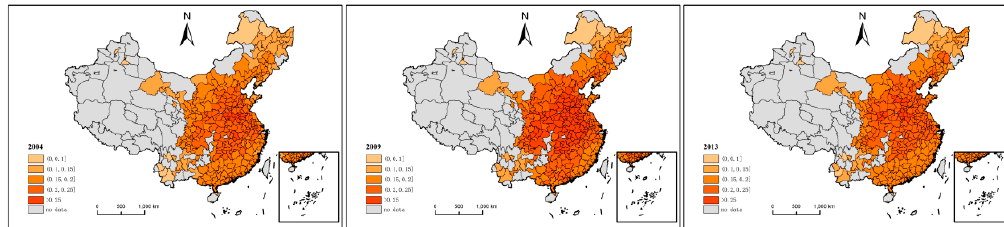
Figure 3. Spatiotemporal distribution of borrowing advanced functions.